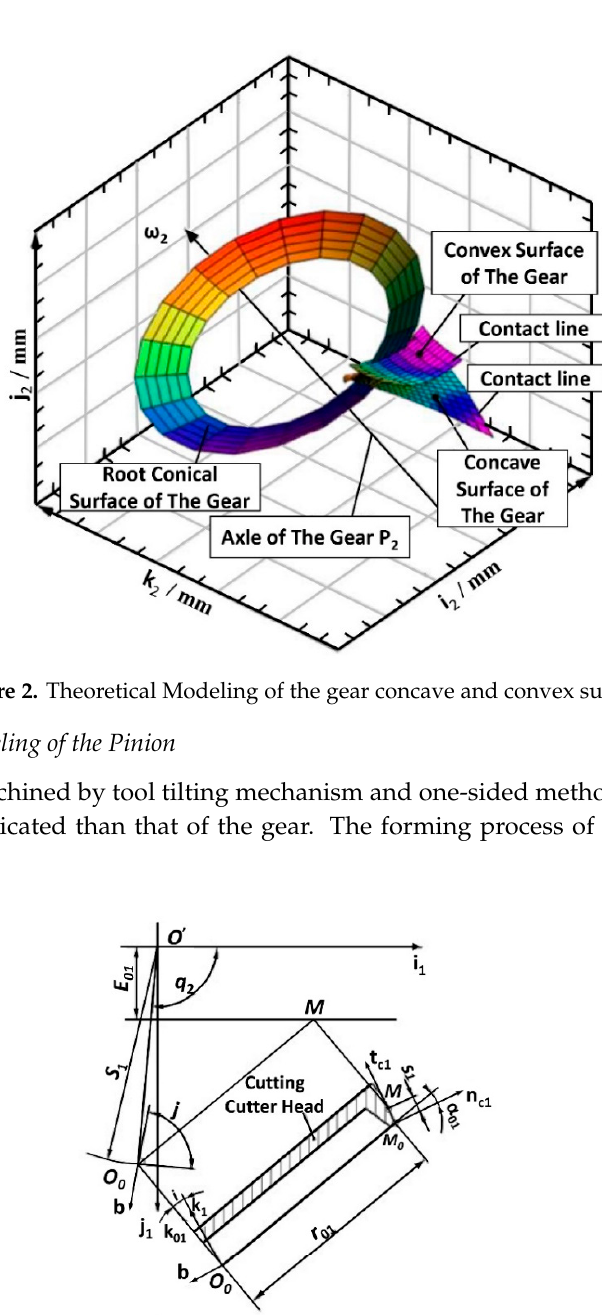
Figure 1. Position relationship between the gear embryo and cutting cutter head.